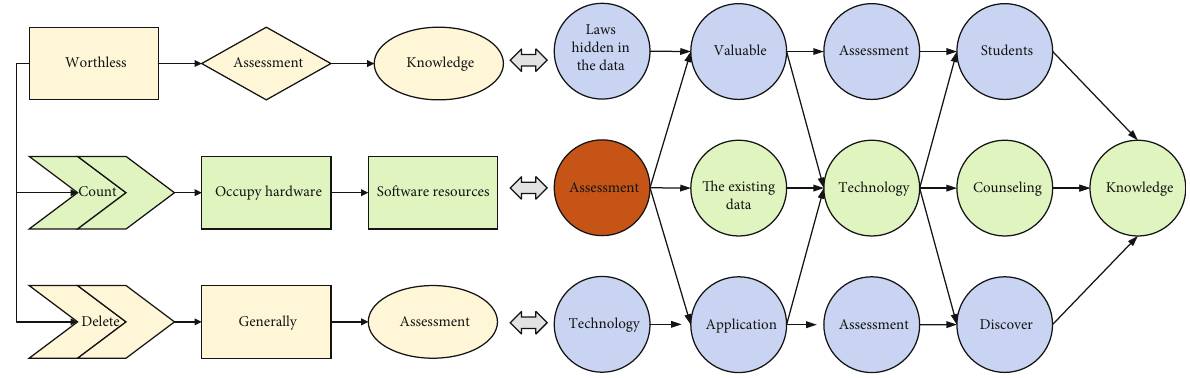
Figure 3: The process of psychological quality assessment of college